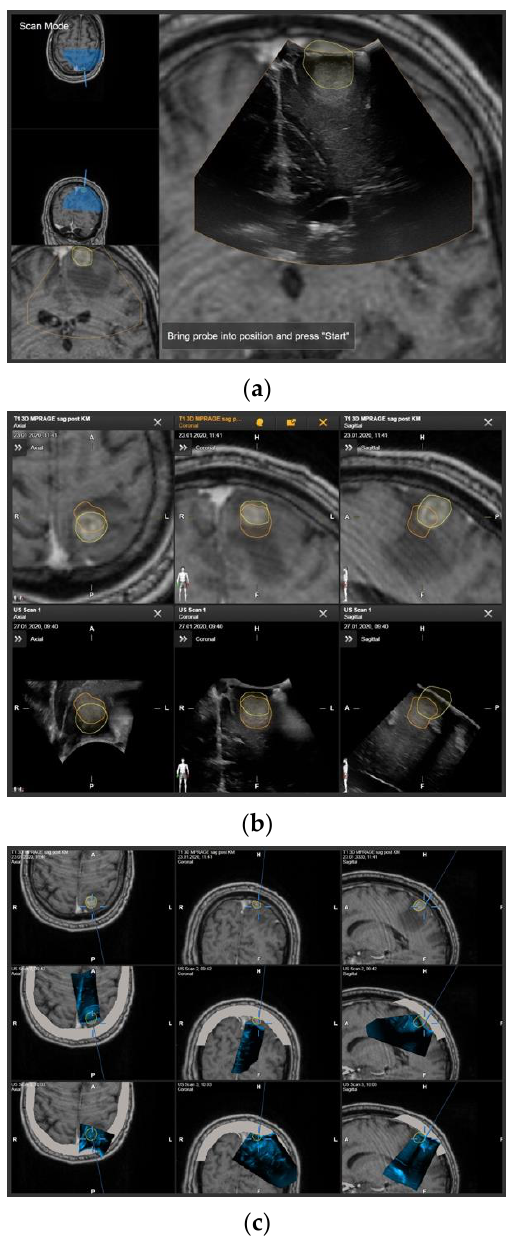
Figure 1. ( a ) Live view of precalibrated ultrasound just before image acquisition. The yellow lines indicate the tumor boundaries segmented in preMRI, depicting a spatial deviation. ( b ) Simultaneous visualization of preMRI and corresponding i3D US slices. Segmented tumor objects are displayed in yellow (preMRI) and orange (i3D US). ( c ) During surgery preMRI and i3D US datasets were acquired during different surgical steps (1st row preMRI, 2nd row before dural opening, and 3rd row after tumor resection) are displayed in an overlay fashion. Yellow lines indicate the preMRI tumor segmentation.